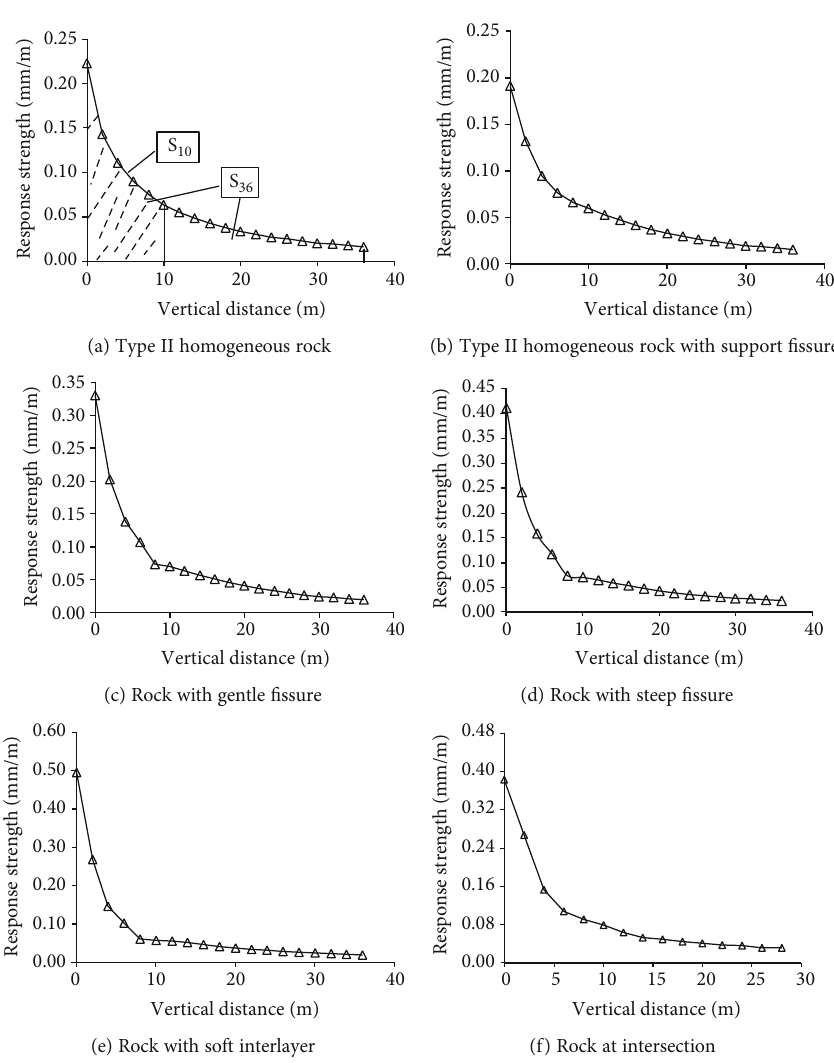
Figure 8: Distance-response intensity curves representing vertical distance of the working face versus unloading